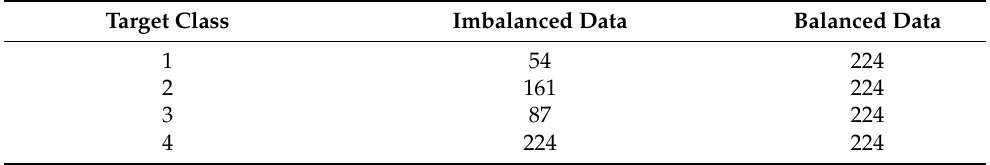
Table 3. Balanced number of data in target variable with SMOTE [60].